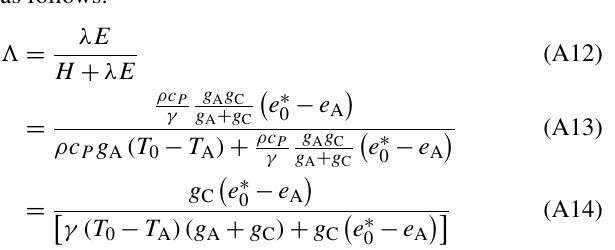
Figure A2. Aerodynamic temperature obtained from STIC1.2 ( T 0-STIC ) vs. radiometric surface temperature ( T R ) over two dif- ferent biomes in the Amazon Basin. The regression equation of line of best fit is T 0-STIC = 0.67 ( ± 0.10) T R + 10.59 ( ± 2.79) with r =